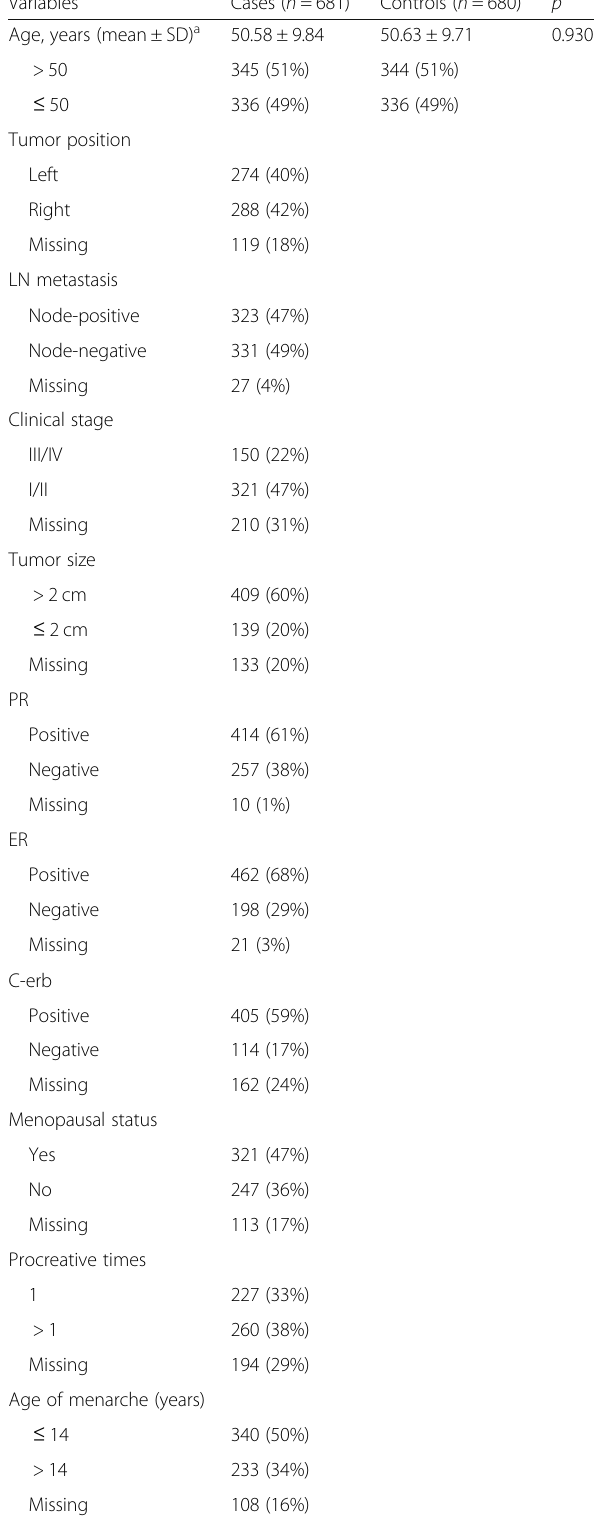
Table 1 Characteristic of breast cancer patients and